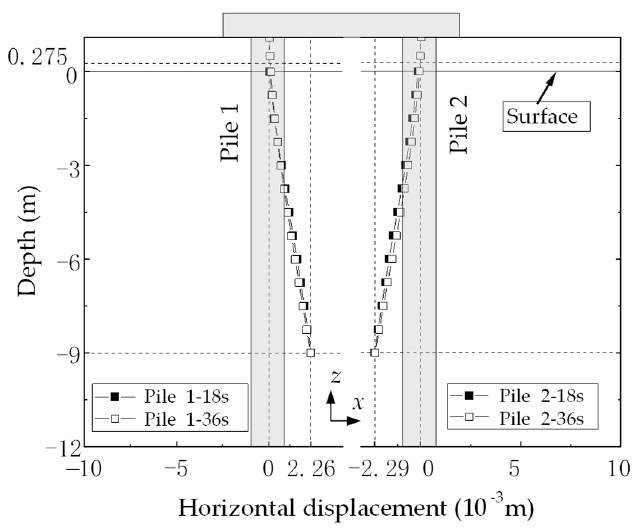
Figure 22. Horizontal displacement of Pile 1 and Pile 2 at 18 s and 36 s.